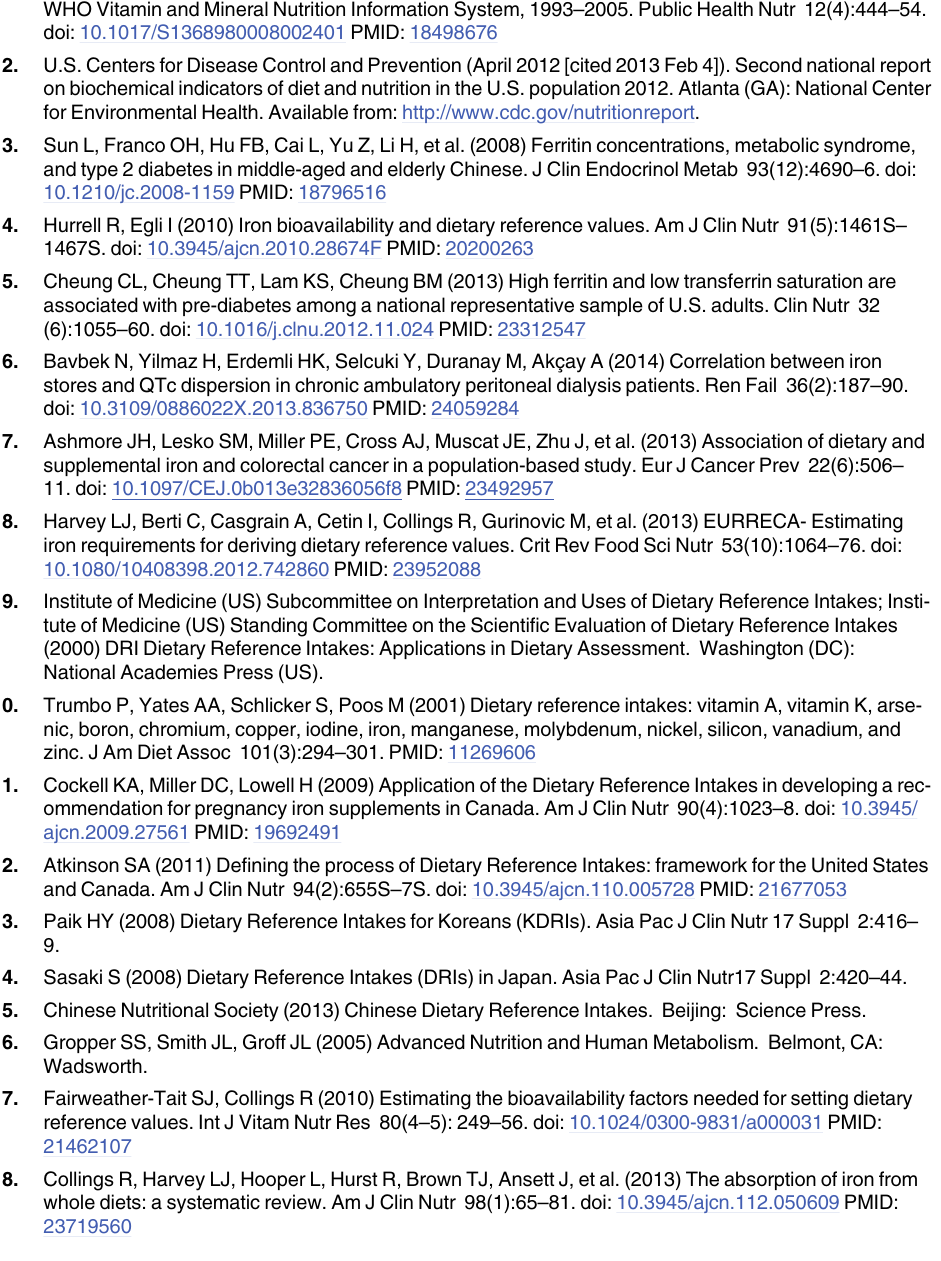
S2 Table. Kolmogorov-Smirnov test for Steamed buns group.